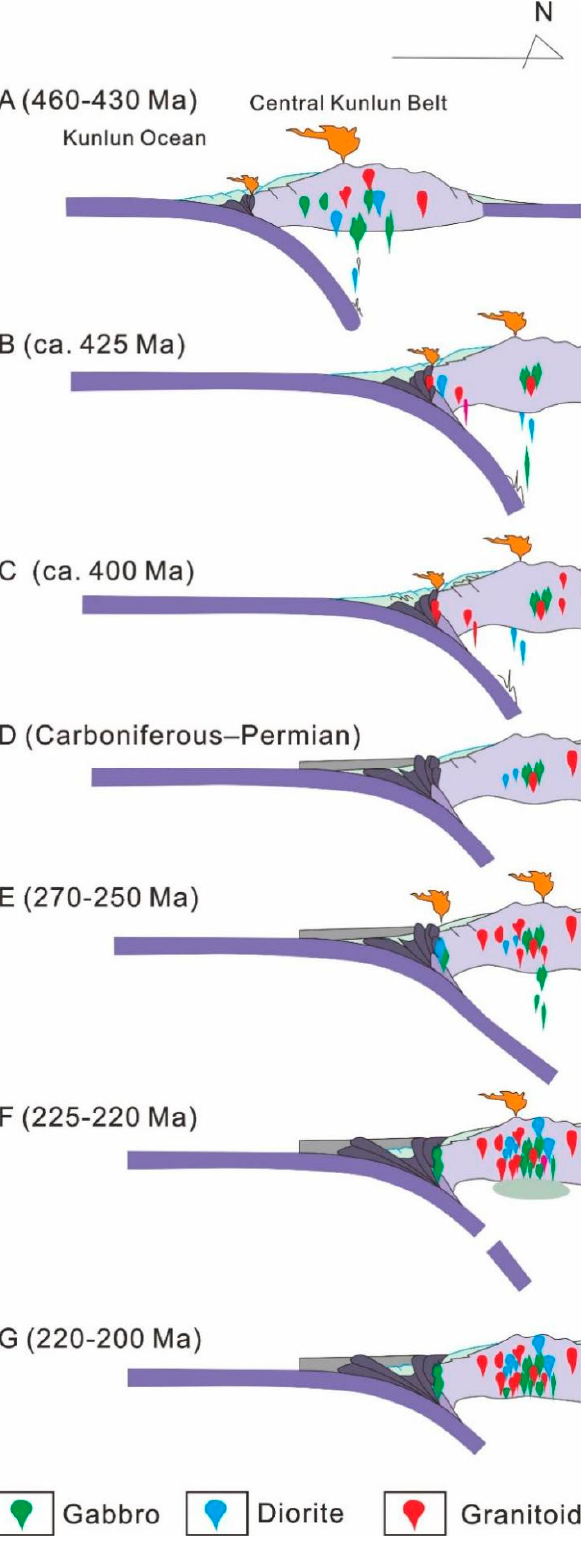
Figure 15. Schematic diagram showing the metal deposits formed in the geodynamic setting in the EKOB (modified after [81]).